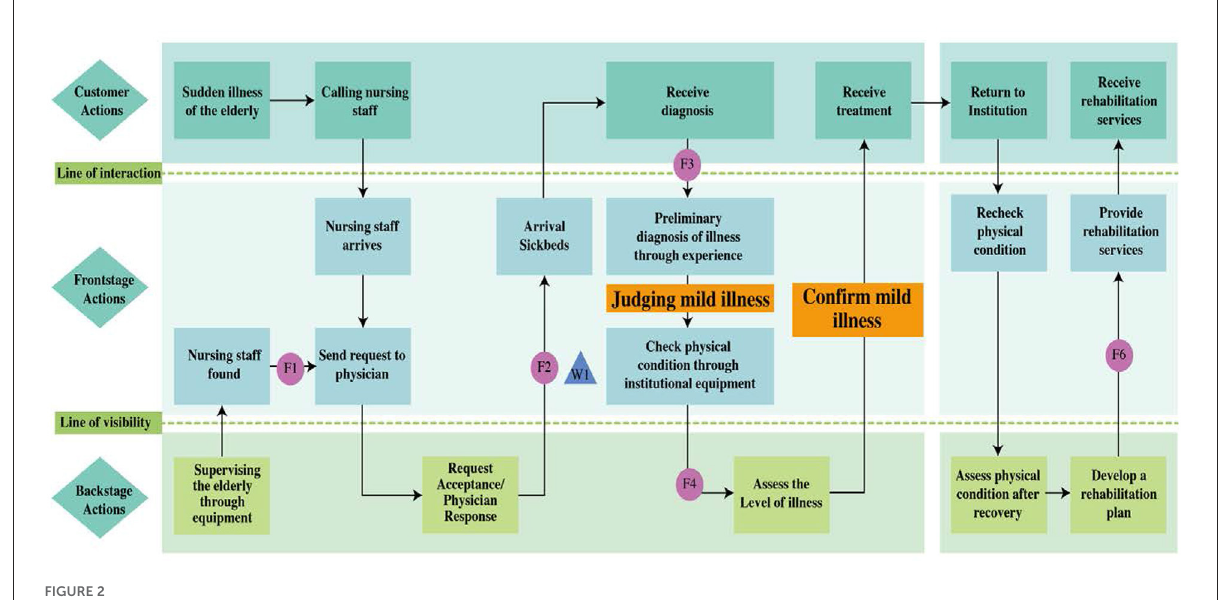
FIGURE2 Service blueprint of CMEC for elderly people with mild illness .